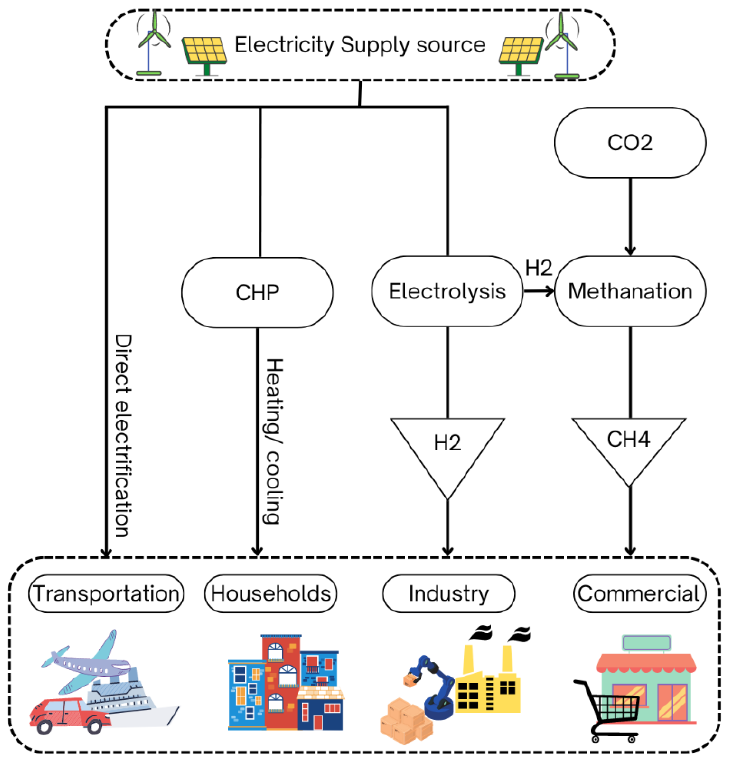
Figure 2. Sector coupling.